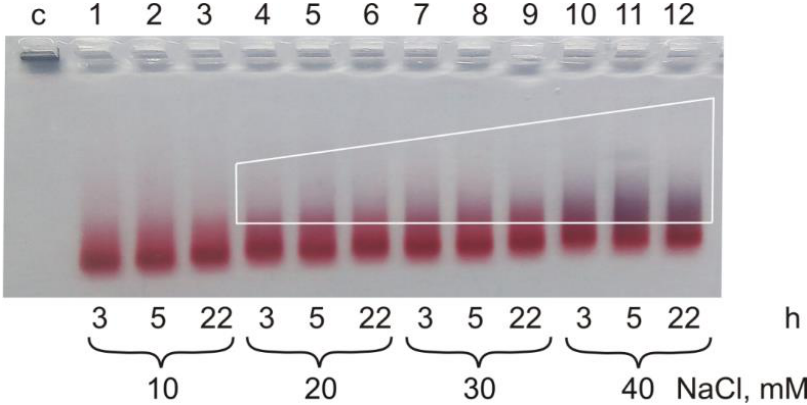
Figure 3. Agarose gel electrophoregram of the cores (Sample II) in the presence of salt in concentration from 10 mM to 40 mM. Agglomeration area is shown by white trapezoid. Incubation time is shown at the image bottom.